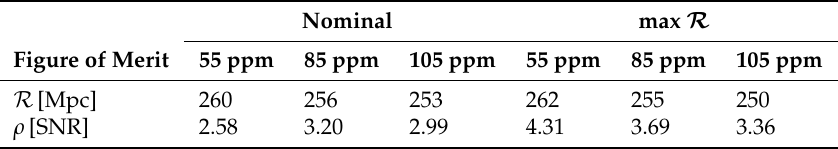
Table 2. Astrophysical figures of merit using transmittances found for the max R configuration with 85ppm in interferometers (ITFs) with RTLs indicated by column headers. Nominal max R Figure of Merit 55 ppm 85 ppm 105